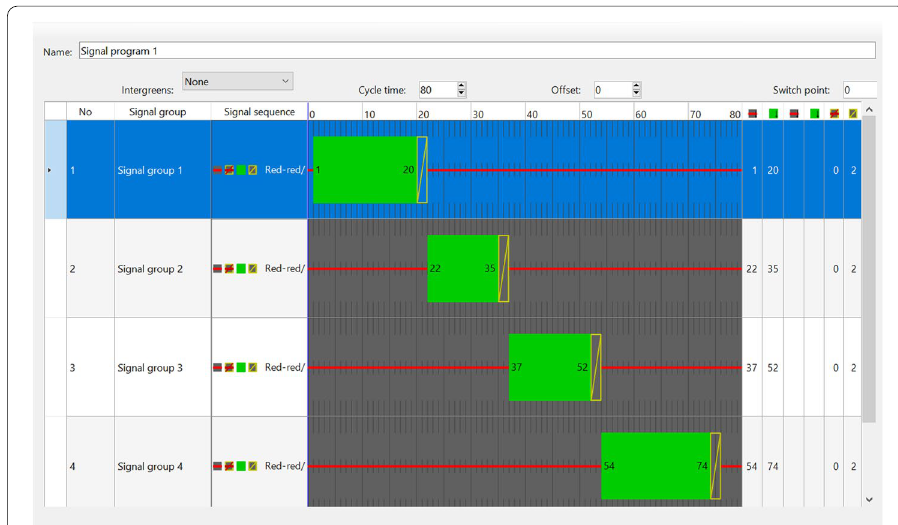
Fig. 9 Visual simulation for queue length of conventional